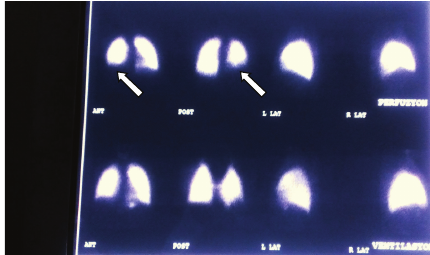
Figure 3: Decreased perfusion in the lower lobe of the right lung.